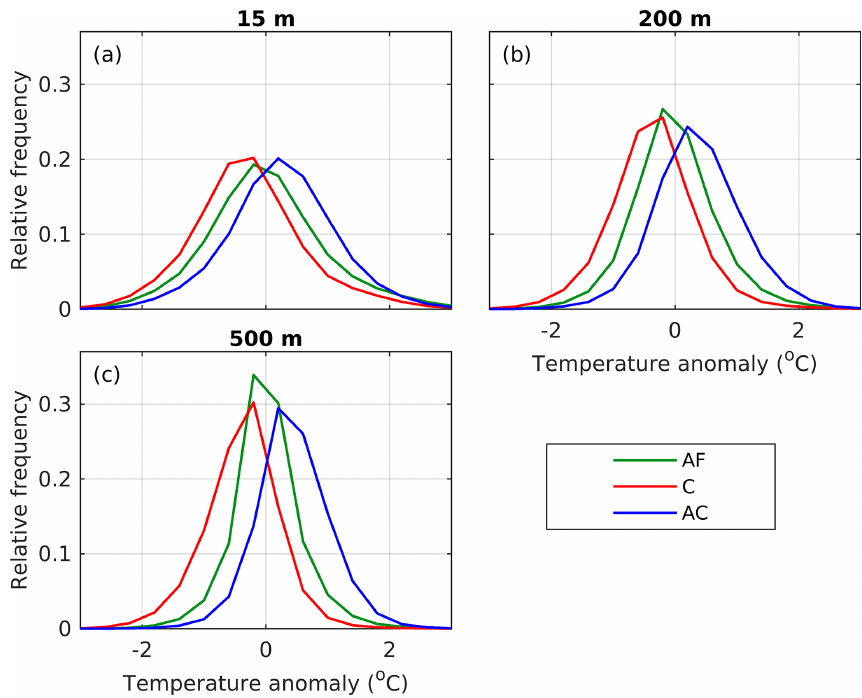
Figure 9. RFDs of temperature anomalies for 3D drifters deployed at (a) 15m, (b) 200m and (c) 500m. The anomalies are relative to a seasonal background climatology from the ROMS fields (see text). RFDs are shown for AF drifters (AF, green), cyclonic ridges (C, red) and anticyclonic ridges (AC,